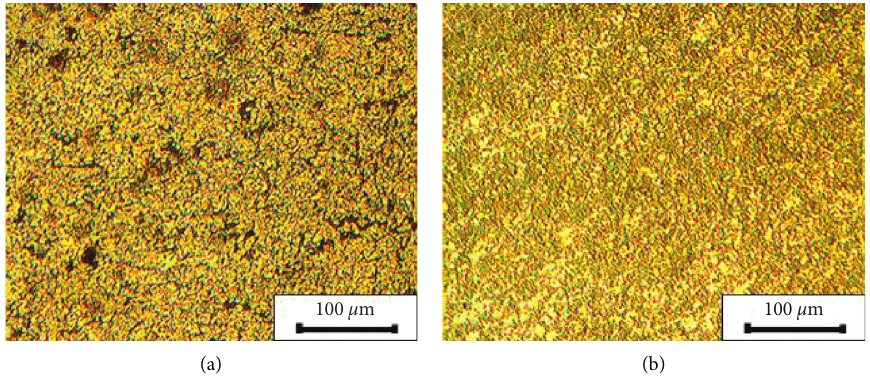
Figure 6: A photographic view of the microstructure of the AA6082-AA7075